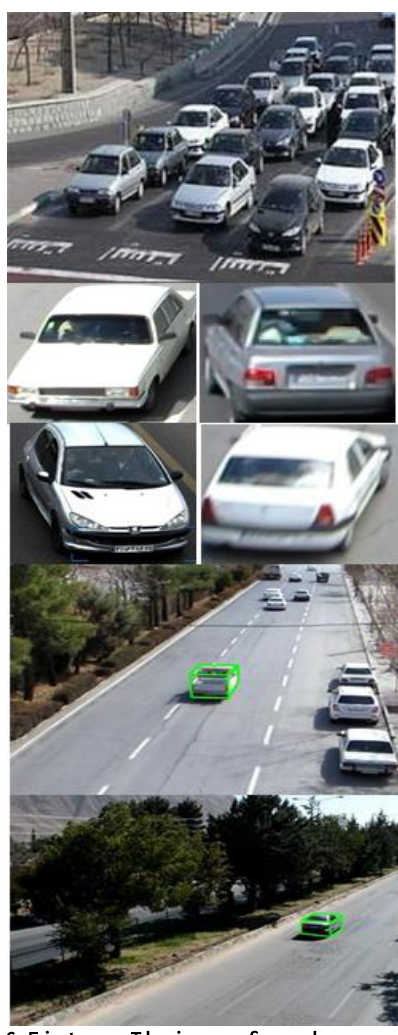
Figure 6. First row: The image of an urban surveillance camera, second and third rows: sample training images, fourth and fifth rows: sample video frame.